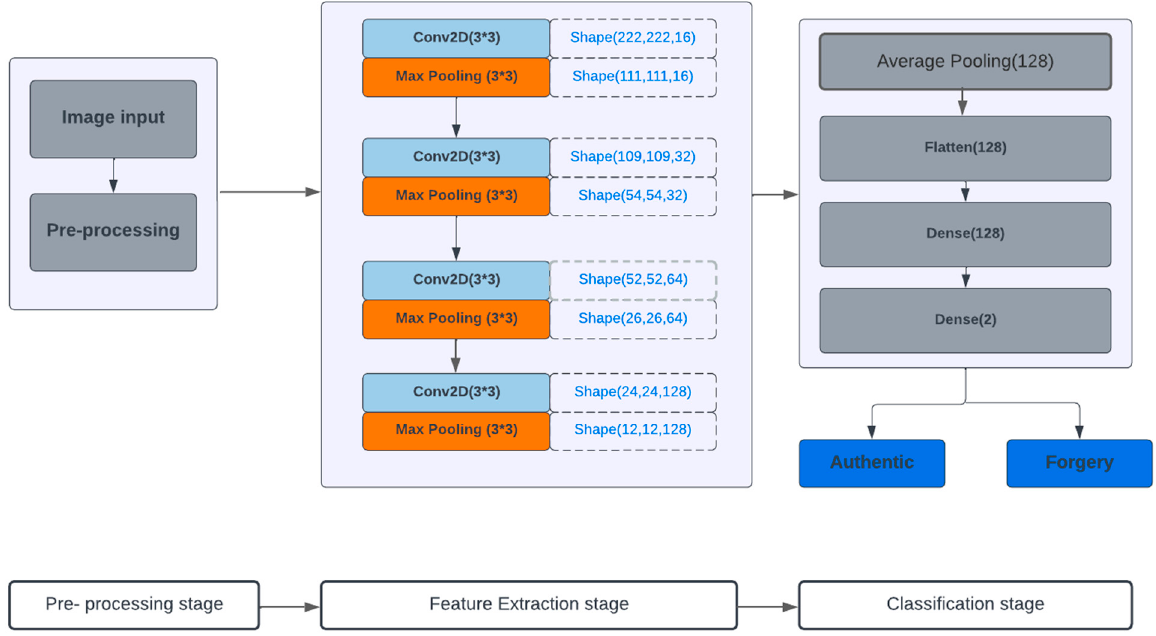
Figure 3. The structure of the proposed algorithm CNN layers.